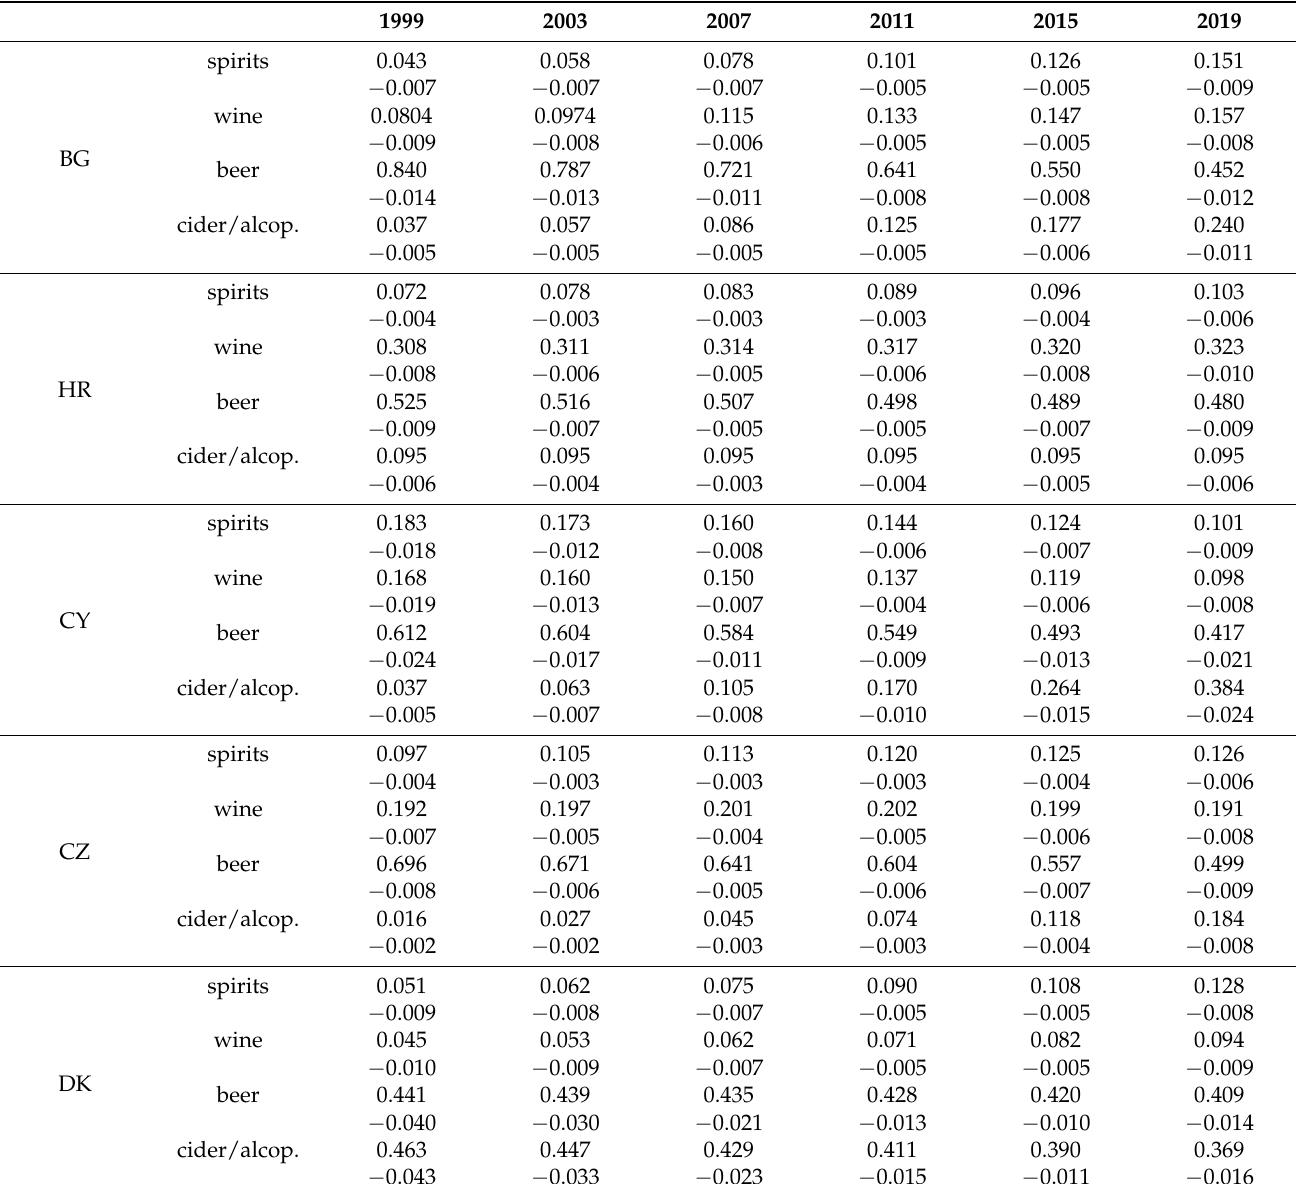
Table A6. Model predictions of beverage proportions in boys, 1999-2019 (margins,